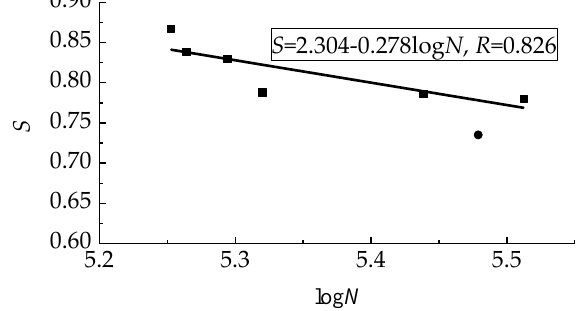
Figure 8. Fitness of S-N curve with test data.